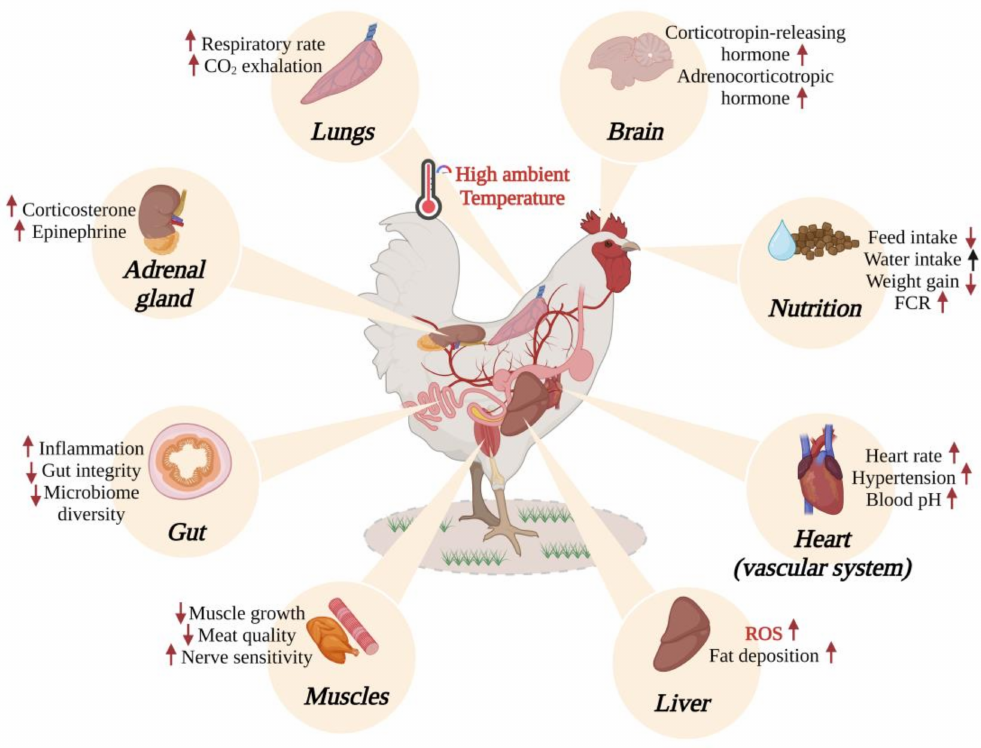
Figure 1. Selected established or suggested effects of high ambient temperatures in broilers. The figure has been realized based on information obtained from previous reports [5,19,20]. Upwards arrows indicate an increase and downward arrows indicate a decrease. Abbreviation: ROS: reactive oxygen